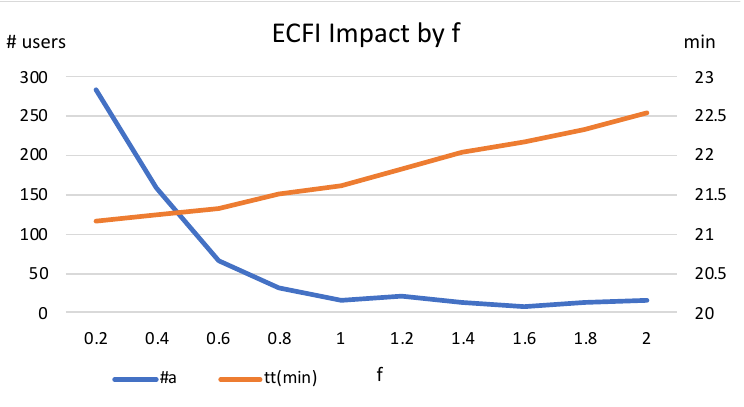
Figure 6. Impact of different factors f with ExpectedCostFutureImpact (with RentFailCost = 3000, ReturnFailCost = 2500, FutRentFailCost = 3000, FutReturnFailCost = 1000, and tf = 60 min).